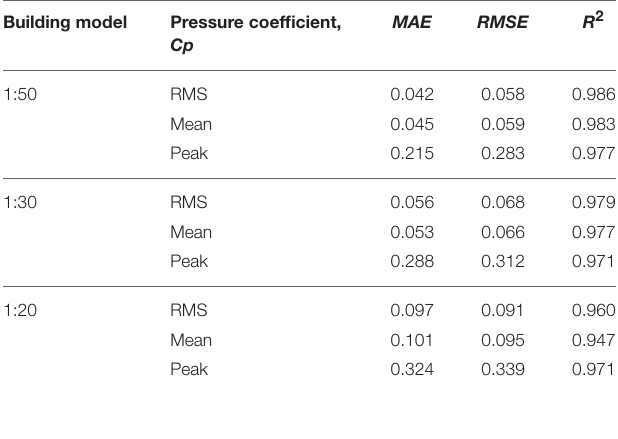
TABLE 3 | Regression performance for ANN test data ( h = 40, 80, 120, 140mm; wide edge windward). Building model